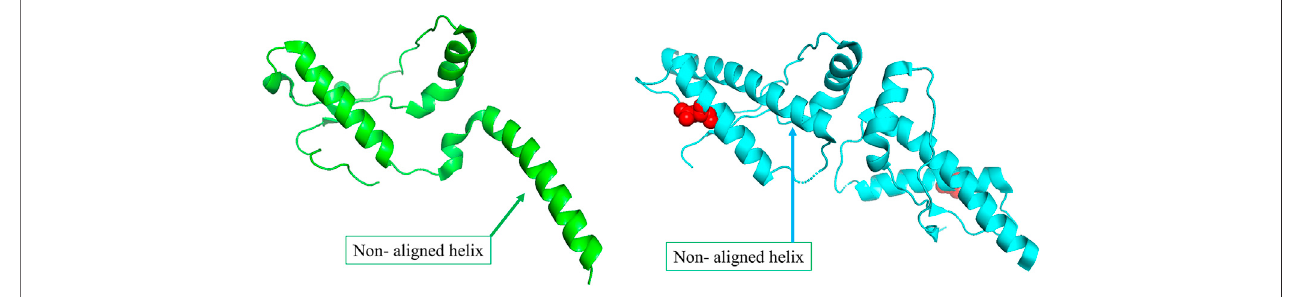
FIGURE 3 | (A) The wildtype conformer (PDB ID: 1I4M) is crystallised as a monomer in the asymmetric unit, although it exists as a dimer functionally. (B) The structure of the disease-causing mutant (PDB ID: 3HEQ) shows conformational change in the non-aligned helix. The mutant residue is shown in red